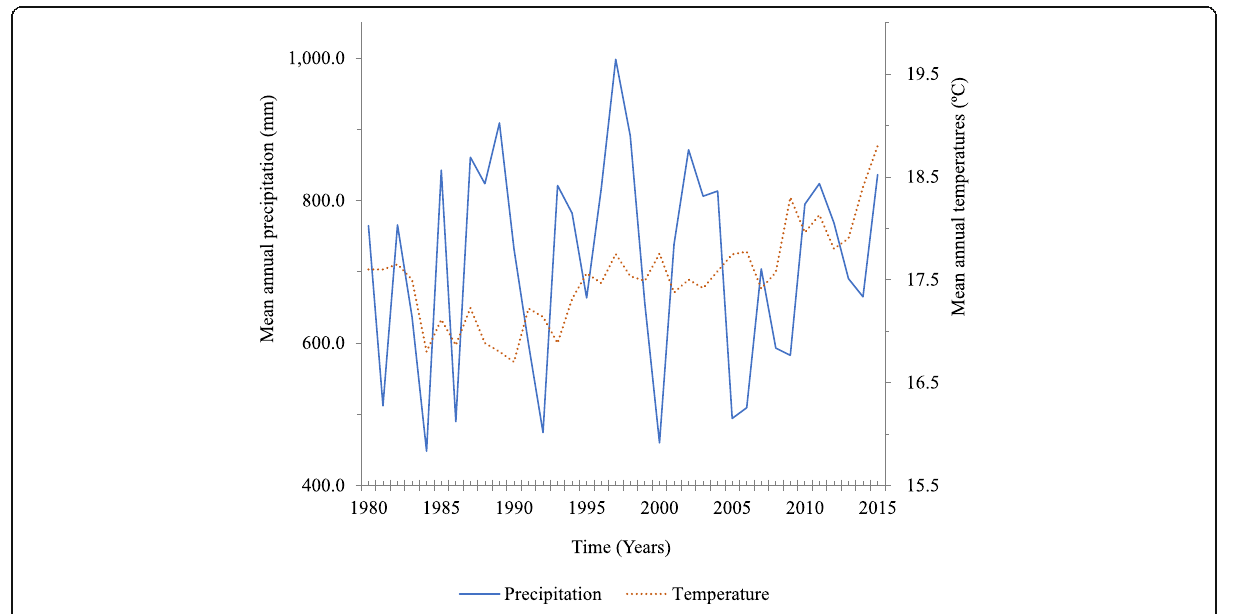
Fig. 2 Mean annual measurements for rainfall and temperature for Trans-Mara East . (Data source: Kenya Meteorological Department, 2017)